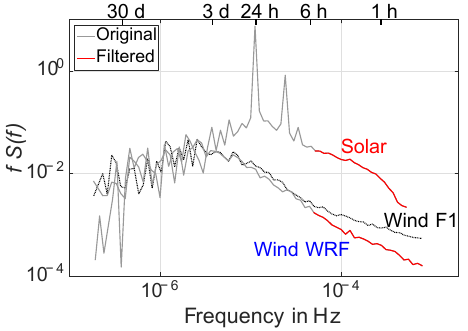
Figure 4. Power spectral density of the WRF wind speed and the solar irradiance for the original time series in black and in red for a time series where all cycle durations higher than 6h are removed with a Fast Fourier Transform filter. The dashed black line shows the Power spectral density for the wind speed measurements for the same year in 50m height at Fino 1.